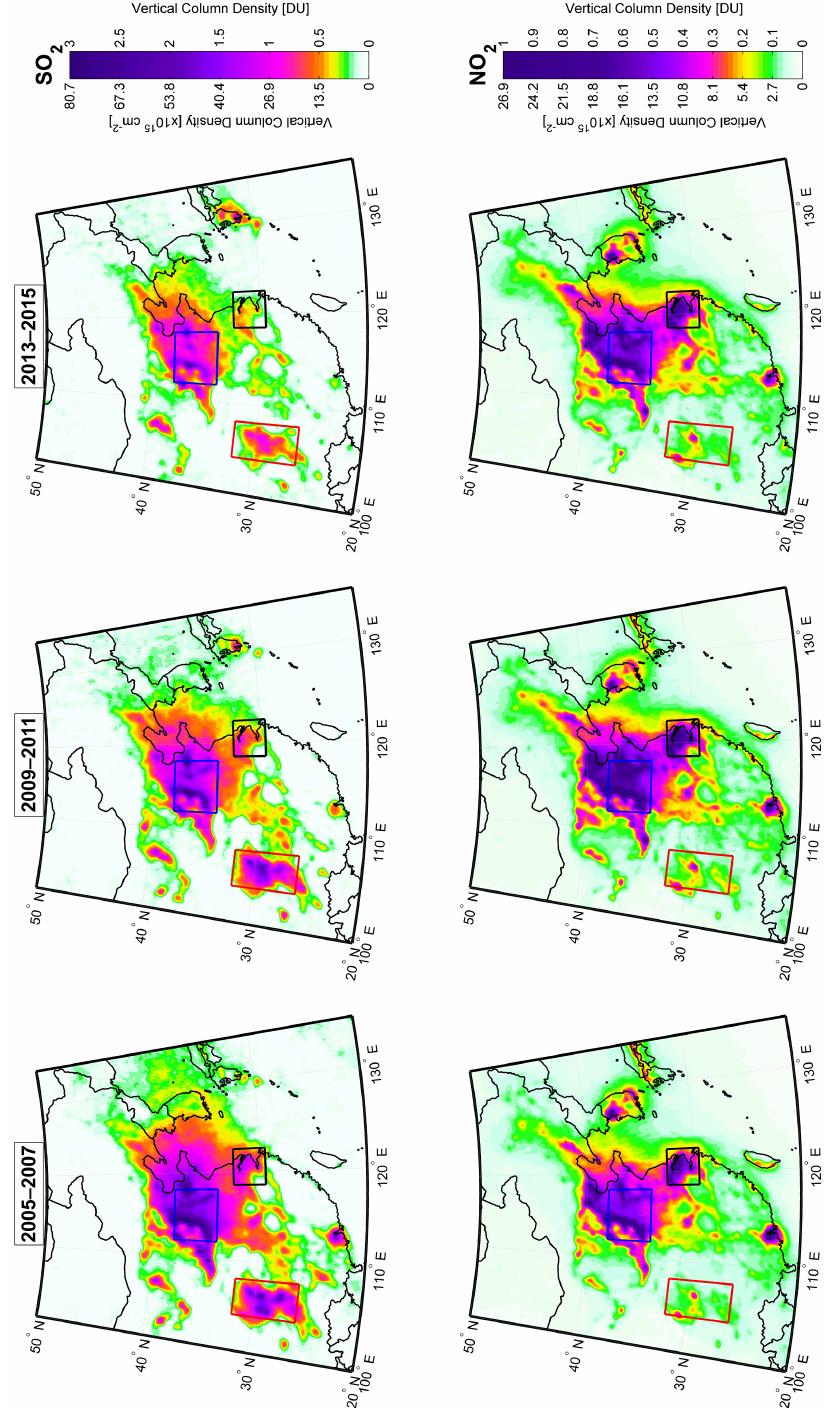
Figure 5. Similar to Fig. 2 but for eastern China. The blue box outlines the North China Plain (NCP) also represented in Fig. 3, red box outlines Sichuan Basin (SB) and black box outlinesa Yangtze River Delta (YRD). The boxes are also shown in Supplement Figs. S1, S3, and